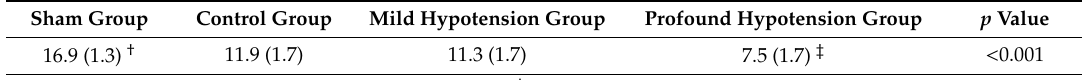
Table 1. The number of normal motor neuron in the anterior spinal cord.